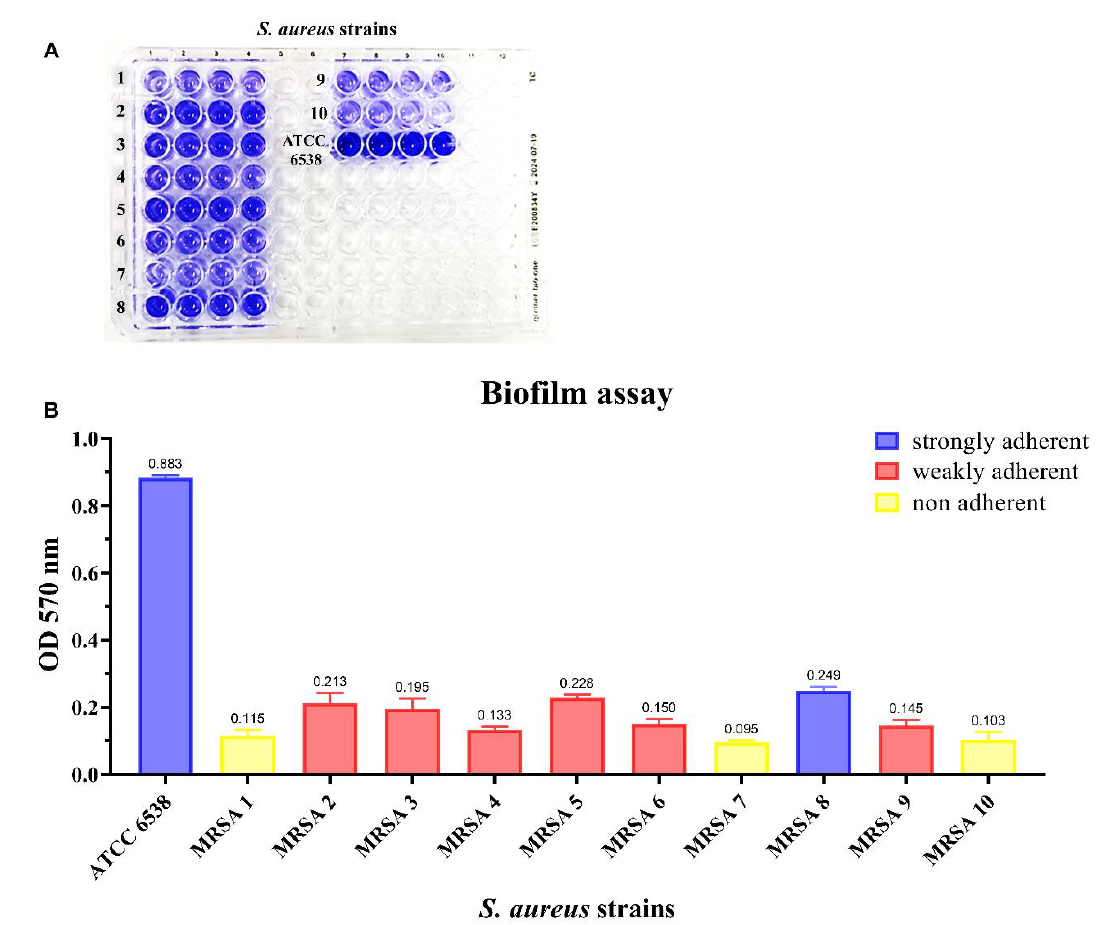
Figure 2. Biofilm quantification assay of methicillin-resistant Staphylococcus aureus strains. ( A). Representative figure of biofilm quantification by crystal violet assay in 96-well microplate. ( B ). Quantitative analysis of biofilm formation. Bacteria were categorized as non-adherent (O.D. ≤ 0.120: yellow histograms), weakly adherent (O.D. > 0.120: red histograms)